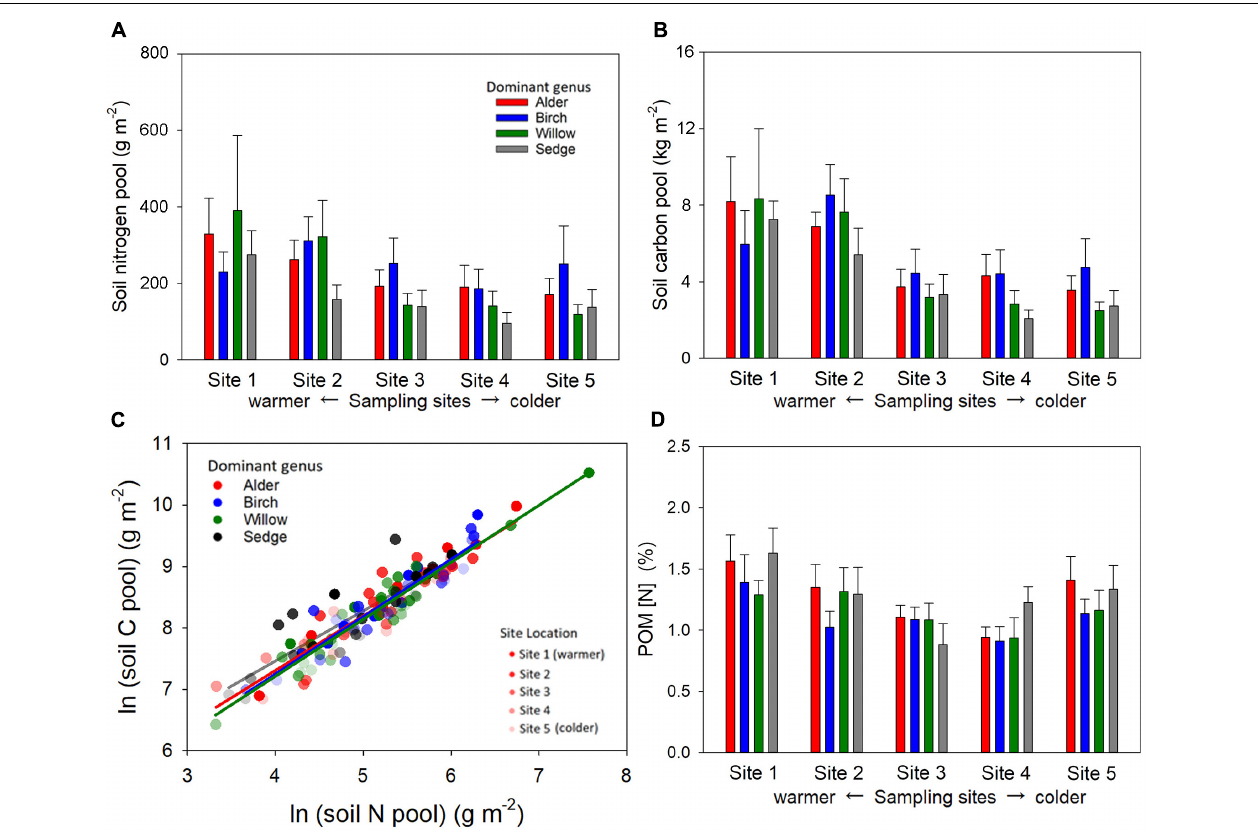
FIGURE 5 | The pool size of soil nitrogen (A) , soil carbon (B) , and the relationship between log-transformed soil carbon and nitrogen (C) in the active soil layer, as well as [N] of particulate organic matter (POM) in the organic layer (D) of the shrub and sedge dominated plots across the five sampling sites. Both soil C and N pool were significantly influenced by site location ( P < 0.001 for soil C, Sites 1, 2 > Sites 4, 5; Site 1 > Site 3; and P = 0.007 for soil N, Sites 1, 2 > Site 4, 5) but not dominant genus ( P = 0.36 for soil C and P = 0.25 for soil N). Soil N was significantly correlated with soil C in both shrub and sedge dominated plots, but the slope of the regression did not significantly differ among plots with different dominant genera ( P = 0.95). Samples from higher latitude sites are indicated with greater transparency in the scatter plot. The [N] of POM in the organic layer was sensitive to site location ( P = 0.014, Site 1 > Sites 3, 4) but not dominant genus ( P =